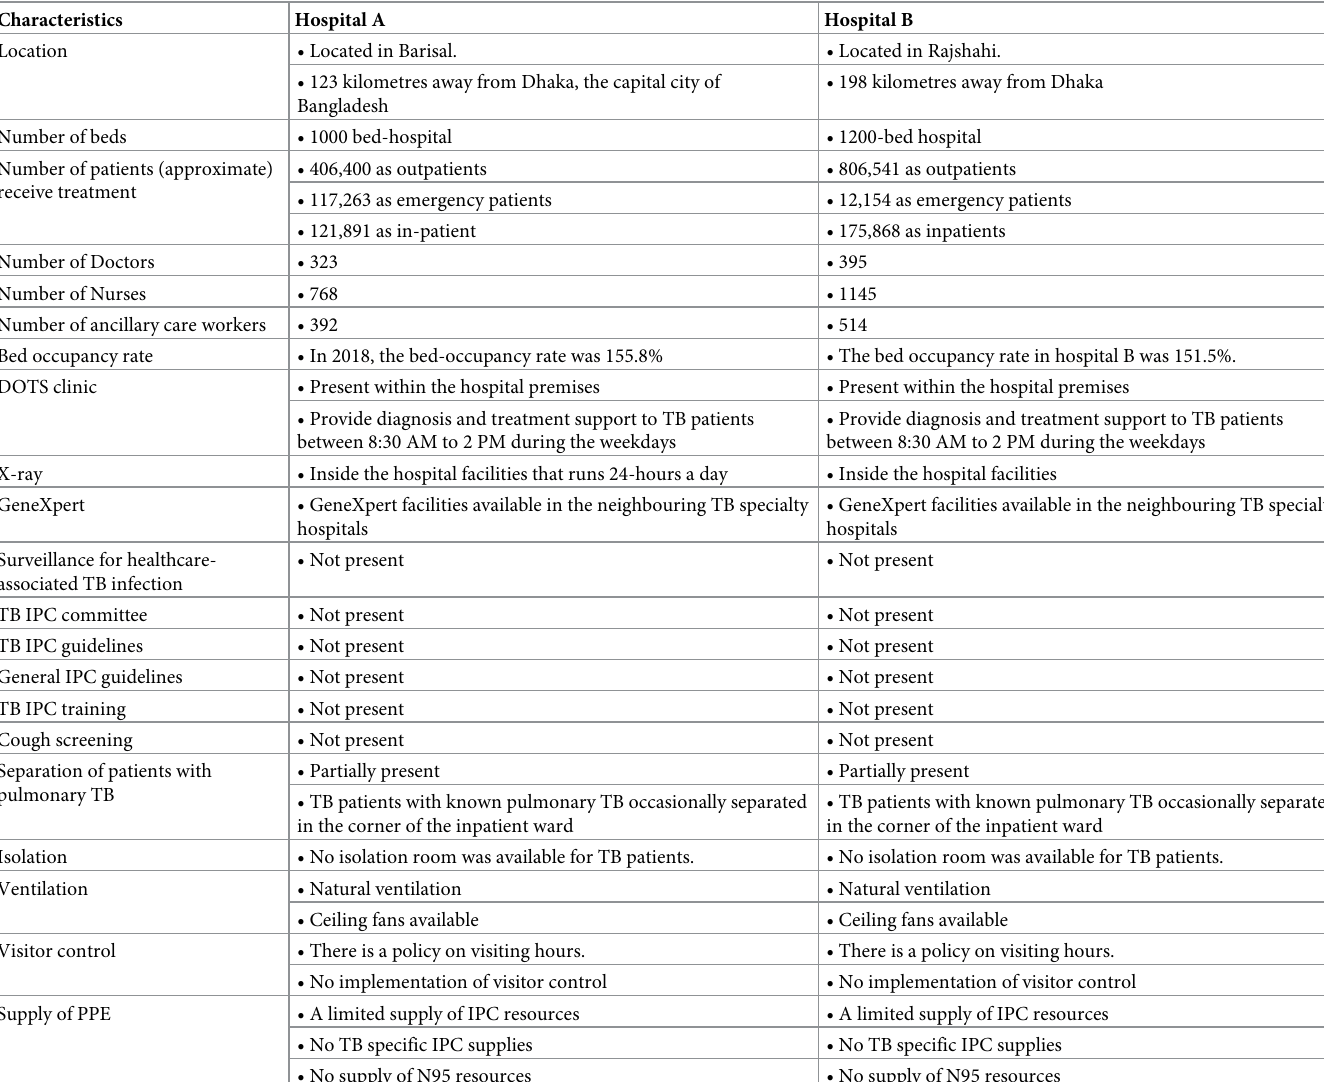
Table 1. Key characteristics of the study hospitals,